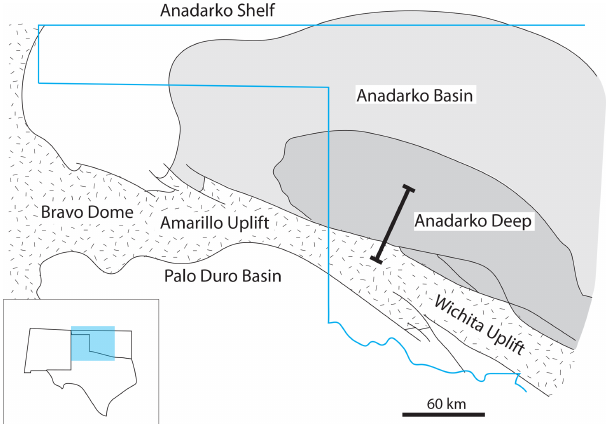
Figure 5. Plan view image of the Anadarko Basin (modified from Hentz, 1994). The bold line denotes the approximate location of the 3D seismic line in Fig. 7. Note that both the Amarillo Uplift and Bravo dome (and much of the Wichita Uplift) are in the